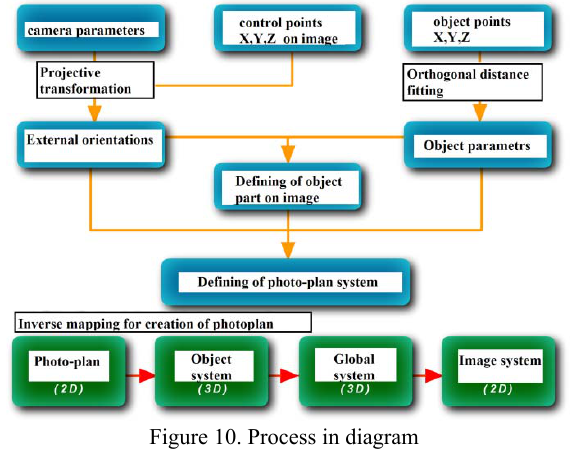
Figure 10. Process in diagram